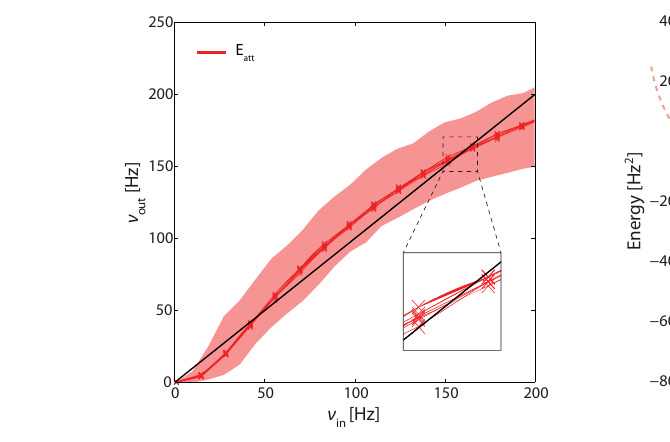
FIGURE 4 | Left panel : effective response functions (ERF) of population E att measured on-chip (see Figure 3). Each red lines represents an average over neurons in E att . Different red lines represent different probabilistic assignments of connectivity (see text). Also indicated is the range of activities obtained from individual neurons (shaded red area). Intersections between